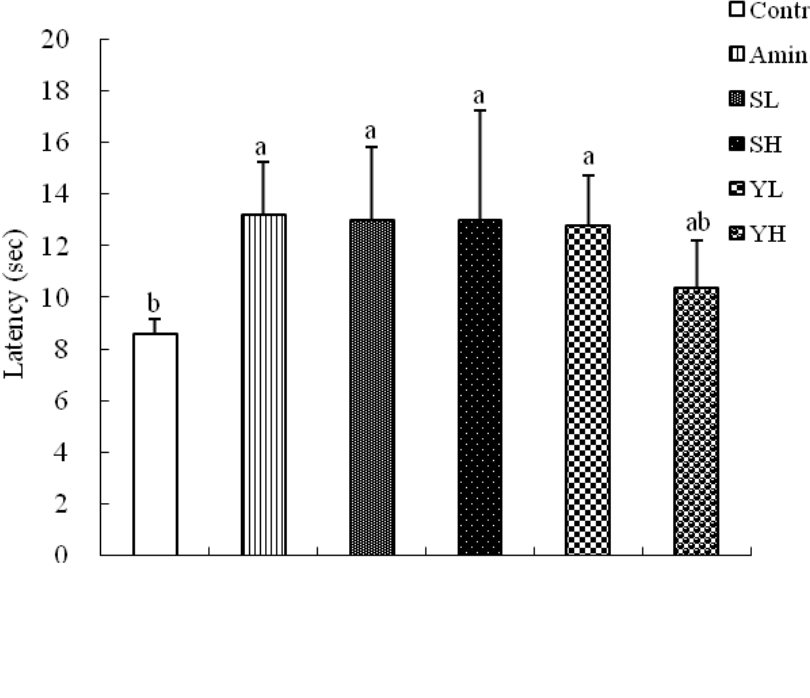
Figure 5. Effects of SoRiTae and Yak-Kong ethanolic seed extracts on thermally-induced pain in mice. Amino: Aminopyrine (50 mg/kg); SL: SoRiTae (100 mg/kg); SH: SoRiTae (200 mg/kg), YL: Yak-Kong (100 mg/kg), YH: Yak-Kong (200 mg/kg). Each values was expressed as the mean ±S.E.M. (n = 6). a-b Means in the same column not sharing a common letter are significantly different (p < 0.05) by Duncan's multiple